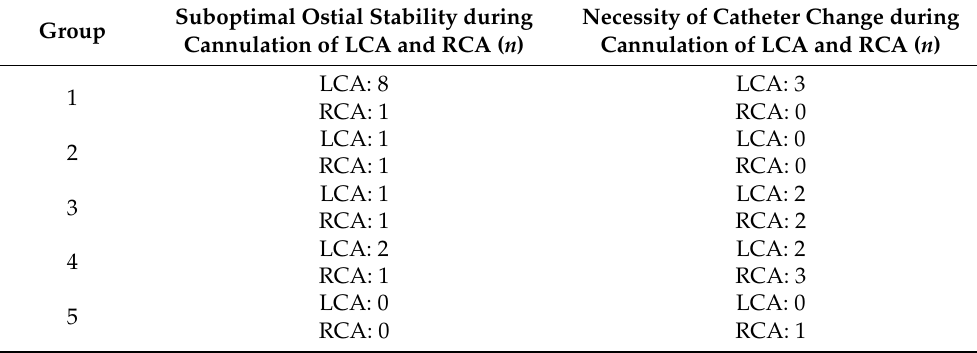
Table 2. Rate of catheter ostial instability and rate of need for the usage of another catheter among study groups in LCA and RCA